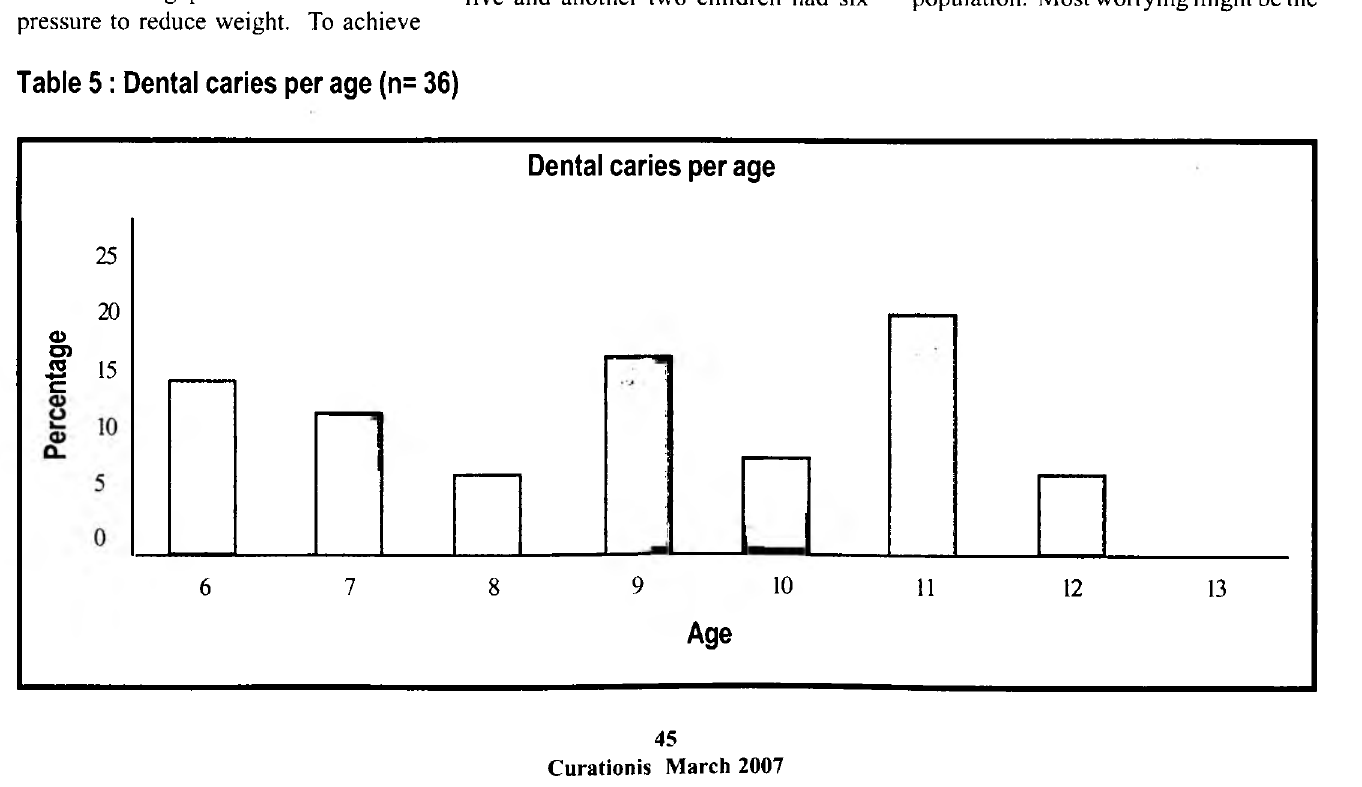
Table 5: Dental caries per age (n= 36)